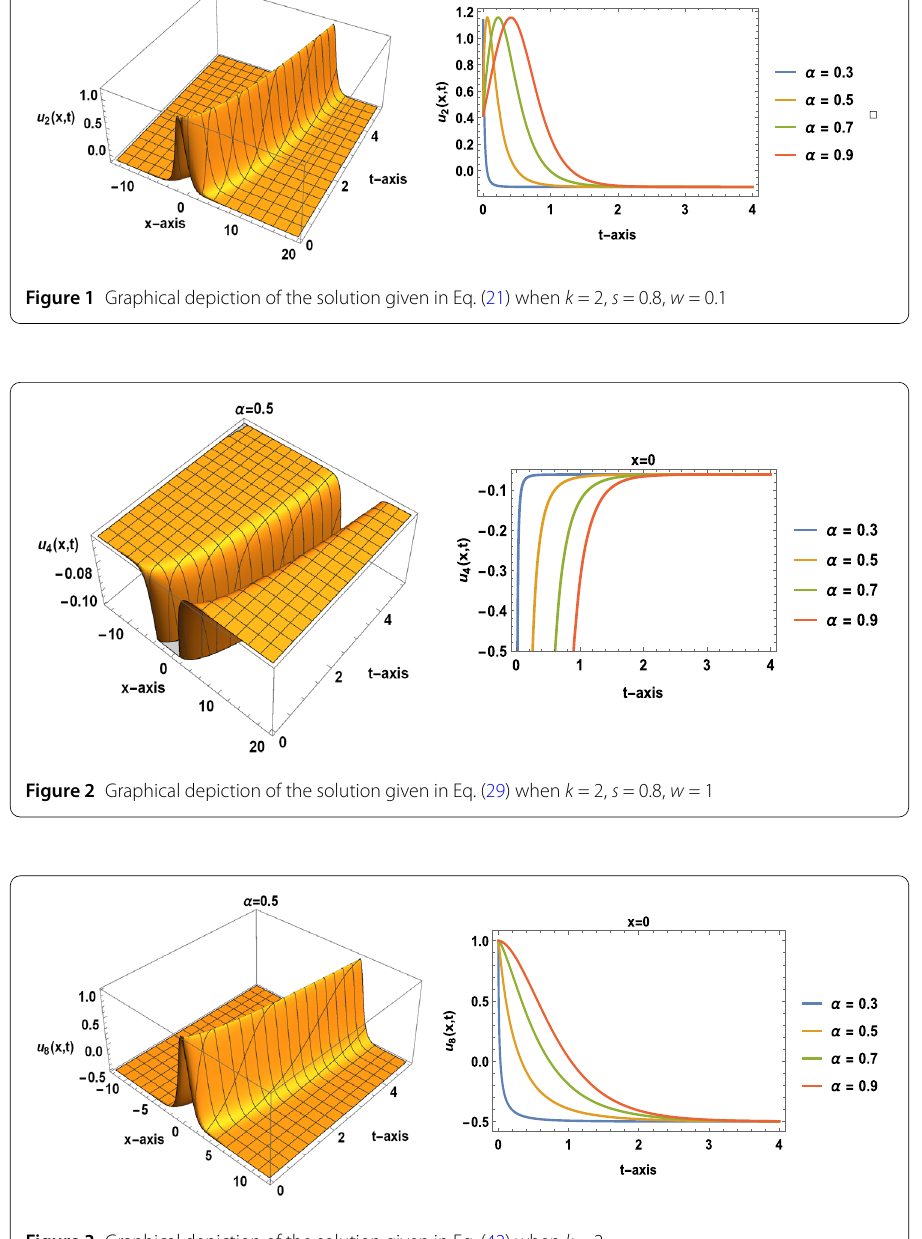
Figure 3 Graphical depiction of the solution given in Eq. (42) when k =